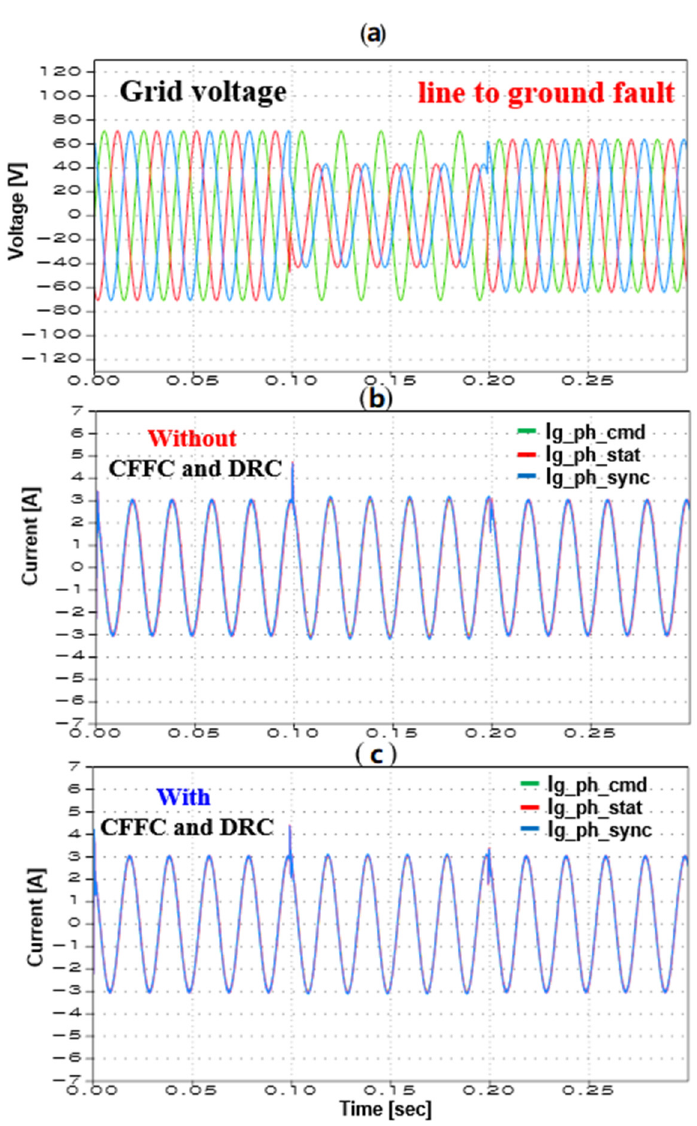
Figure 8. Simulation results of GCI system phase current ( a ) when line-to-ground grid fault occurs, ( b ) without and ( c ) with the CFFC and DRC.